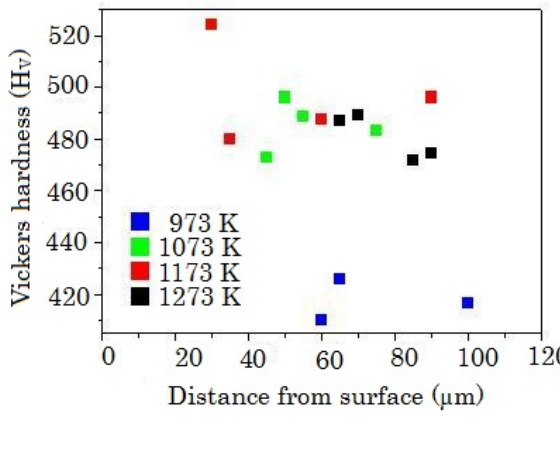
Figure 15. Annealing temperature dependence of the Vickers hardness as a function of the distance from the surface coated with boron powder